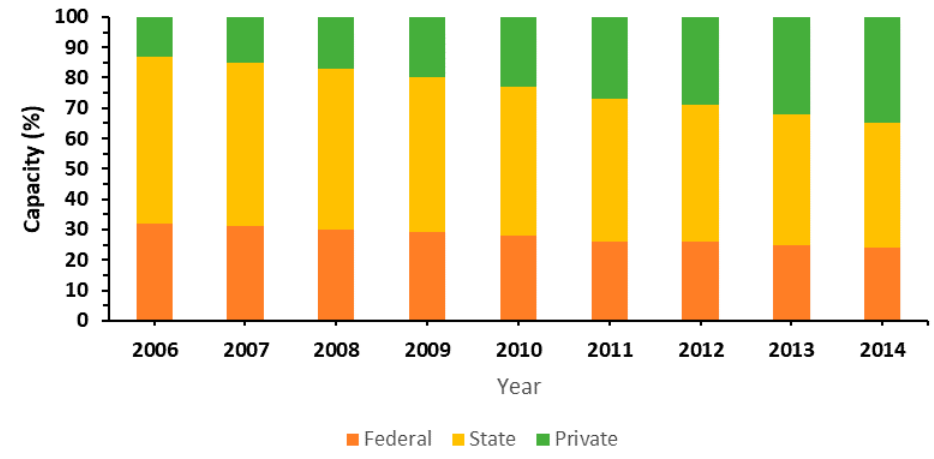
Figure 6. Capacity of power generation by ownership in India [11].